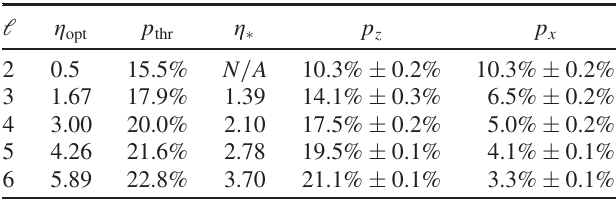
TABLE I. Thresholds for the MWPM decoder in the code- capacity model. Simulations were done on lattices of size 17 × 17 at most.